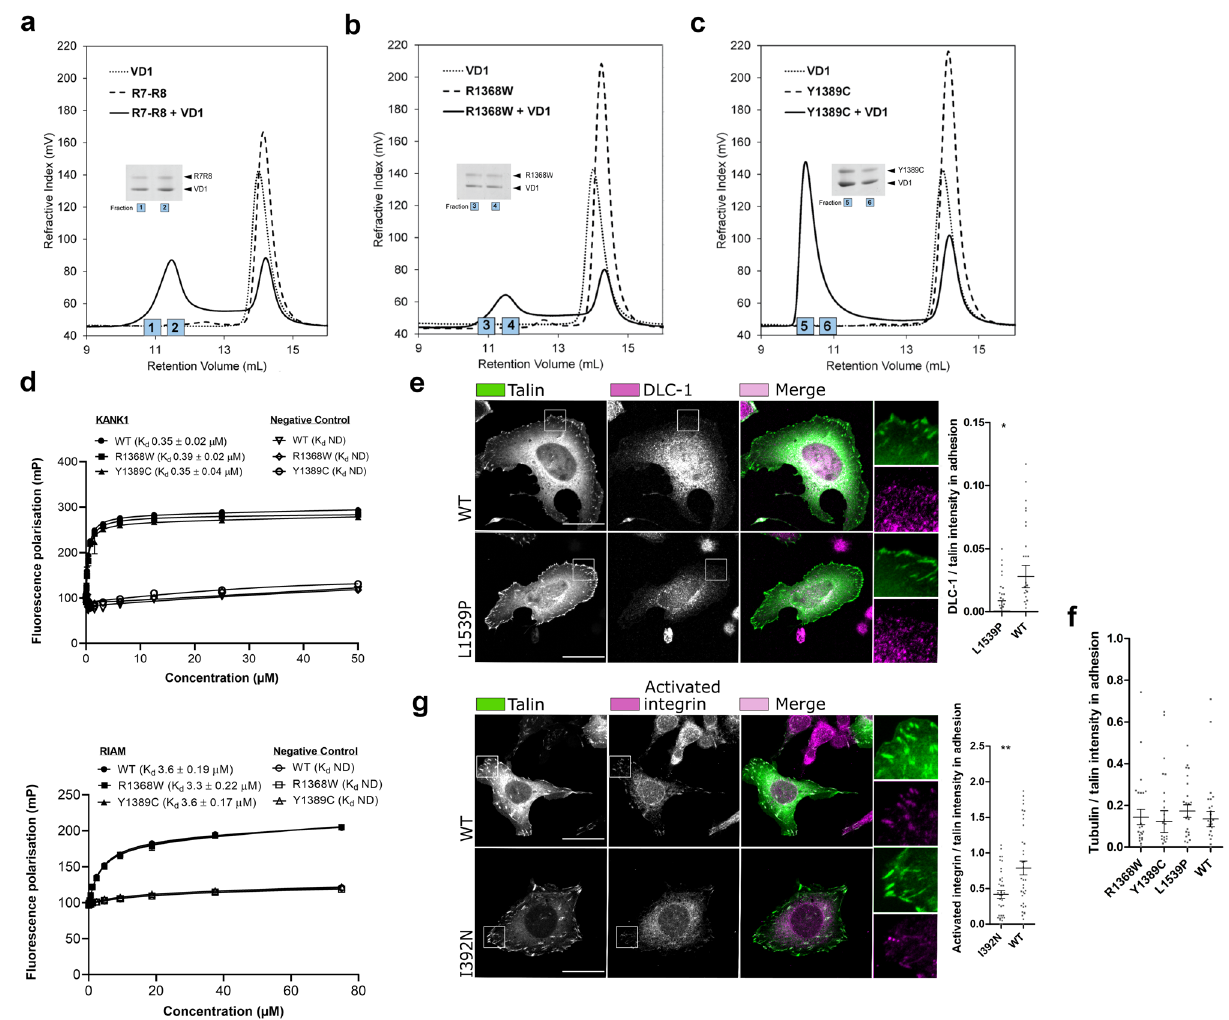
Figure 6. Mutations alter the interaction and colocalisation of talin with vinculin, DLC-1 and activated β1– integrin. ( a – c ) Vinculin Vd1 binding analysed by size exclusion chromatography for R7–R8 WT ( a ), R7–R8 R1368W ( b ) and R7–R8 Y1389C ( c ) purified as recombinant proteins in E. coli . The SDS-PAGE gel of the elution fractions is shown. ( d ) Fluorescence Polarisation (FP) assay for purified R7–R8 WT/mutant binding to KANK (top) and RIAM (bottom) peptides. R7–R8 R1368W and R7–R8 Y1389C showed no significant changes in the interaction with KANK and RIAM compared with R7–R8 WT. Fluorescence polarisation assays were performed using protein serially diluted from a starting concentration of 60 µM with target KANK1 (30–68) peptide at 1 µM and 75 µM with target RIAM (4–30) peptide concentration at 1 µM. Measurements were taken using a CLARIOstar plate reader (BMGLabTech) at 20 °C. GraphPad Prism 7 software was used for data analysis with one-site total binding equation used to generate a K d . ( e ) Representative confocal immunofluorescence images of the co-localisation of DLC-1 in the TLN1 –/– TLN2 –/– mouse kidney fibroblast cells transfected with full length talin WT and L1539P. ( f ) Data obtained from the colocalisation of tubulin in adhesion sites. ( g ) Representative confocal immunofluorescence images of the co-localisation of activated integrin CD29 organisation in the cells transfected with full length talin WT and I392N. SUM projections of z-stacks of cells expressing GFP-tagged talin-1 (WT and/or point mutated) and immunolabeled against integrin CD29 or DLC-1, and ~ 30 cells per